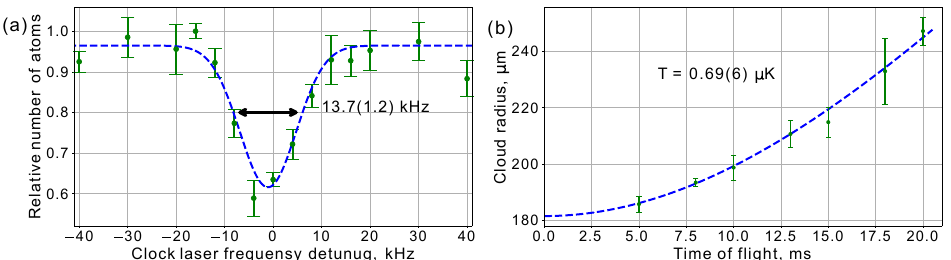
Figure 3. ( a ) Clock line spectroscopy in free-space using vertical clock laser beam: relative number of atoms remained after clock transition excitation depending on clock frequency detuning from resonance. ( b ) Atomic cloud vertical size (radius at 1/e level) during the time-of-flight experiment. The temperature T ver = 0.69 ( 6 ) µK explains 12kHz of the linewidth which is consistent with clock line